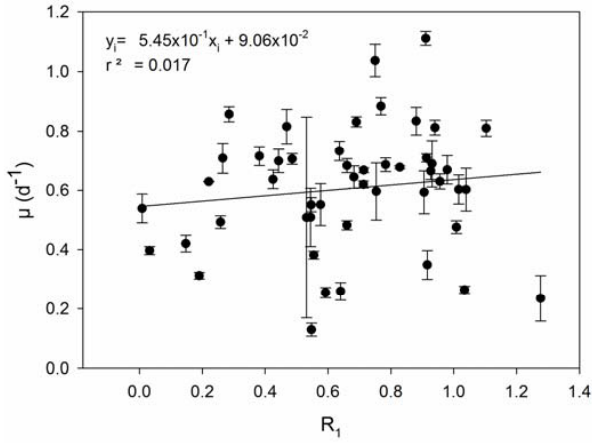
Figure 1. Resistance capacity R 1 (calculated as the ratio between the number of cells that did not lyse after incubation with viruses and the number of cells in the non-inoculated controls) plotted against growth rate ( µ ). Error bars show standard deviation ( n = 3).